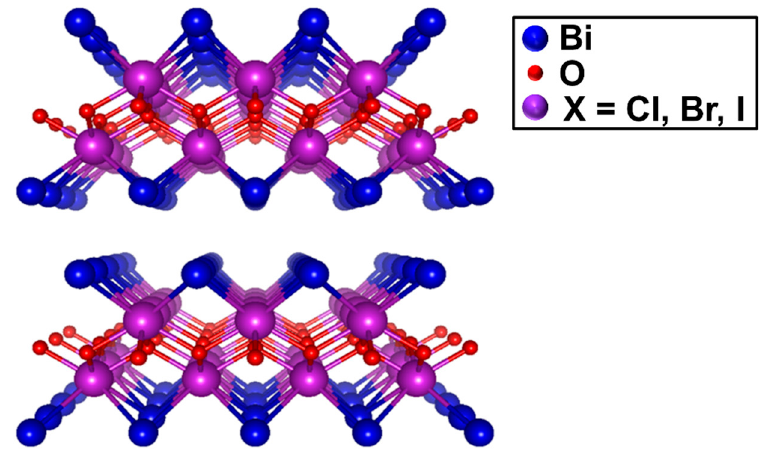
Figure 1. Crystal structure of the BiOX systems (space group P 4/ nmm , D 4h symmetry) with stoichiometric X-Bi-O-Bi-X Bi-layers stacked along the c axis. Bismuth, oxygen, and halide ions are denoted by purple, red and blue spheres, respectively.